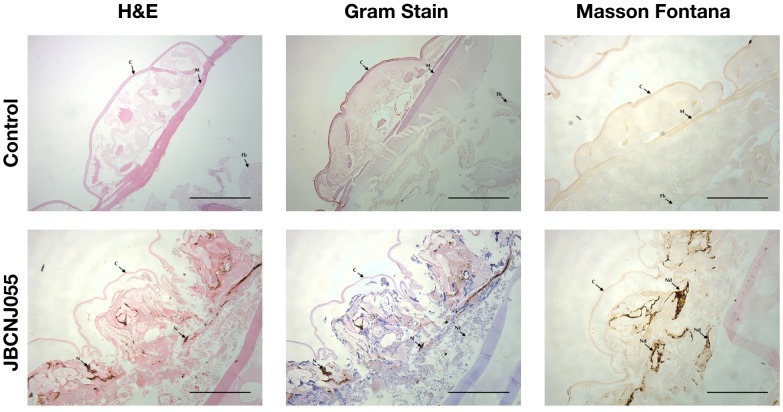
Comparison of G. mellonella histopathology of control and infected groups after 72 h incubation after inoculation with 105 CFU of JBCNJ055. Sections were stained with H+E, Gram-stain and Masson Fontana (highlighting melanin deposition). Infected groups show distinct loss of tissue structure, systemic proliferation of Gram-positive bacteria and a large production of melanin within peripheral tissues indicative of systemic pathogenicity. Scale bars represent 1 mm. C, Cuticle; M, Muscle layer; N/Nd, Nodules; Fb, Fat body; Nc, Necrosis.